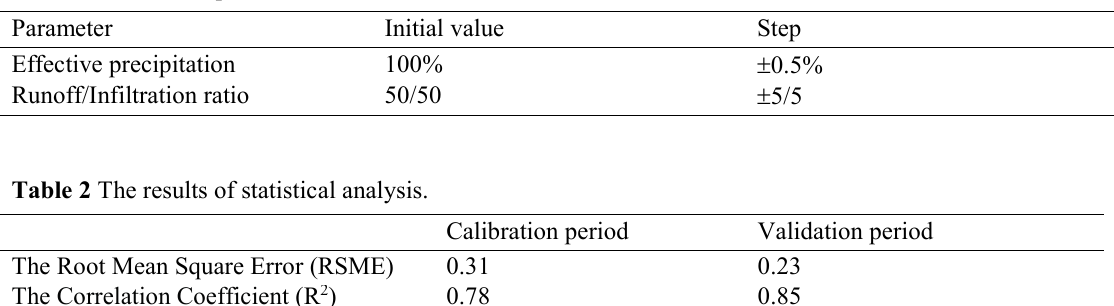
Table 1 Calibration parameters of WEAP model.